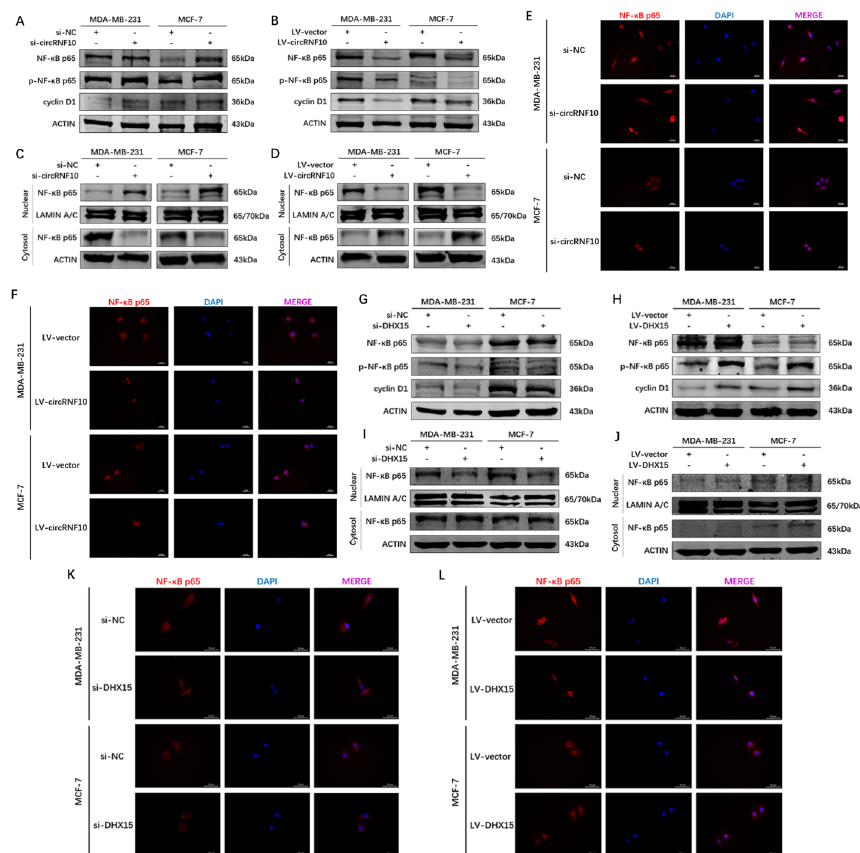
Fig. 4 CircRNF10 and DHX15 were involved in the activation of NF-κB signaling pathway. A Western blotting assay showing the expression of p65, p-p65 (S536), and cyclin D1 in BC cells in si-circRNF10 group and control. B Western blotting assay showing the expression of p65, p-p65 (S536), and cyclin D1 in BC cells in LV-circRNF10 group and control. C Western blotting presenting the cytoplasmic and nuclear p65 levels in si-NC group and si-circRNF10 group of BC cells. D Western blotting presenting the cytoplasmic and nuclear p65 levels in LV-vector group and LV-circRNF10 group of BC cells. E IF assay indicating the subcellular localization of p65 in si-NC group and si-circRNF10 group of BC cells. Red: p65, blue: DAPI. F IF assay indicating the subcellular localization of p65 in LV-vector group and LV-circRNF10 group of BC cells. Red: p65, blue: DAPI. G Western blotting analysis showing the influence of si-DHX15 on expression of p65, p-p65 (S536), and cyclin D1 in BC cells. H Western blotting analysis showing the influence of LV-DHX15 on expression of p65, p-p65 (S536), and cyclin D1 in BC cells. I Western blotting analysis presenting the cytoplasmic and nuclear p65 levels in si-NC group and si-DHX15 group of BC cells. J Western blotting analysis presenting the cytoplasmic and nuclear p65 levels in LV-vector group and LV-DHX15 group of BC cells. K IF assay showing the subcellular localization of p65 in si-NC group and si-DHX15 group of BC cells. Red: p65, blue: DAPI. L IF assay showing the subcellular localization of p65 in LV-vector group and LV-DHX15 group of BC cells. Red: p65, blue: